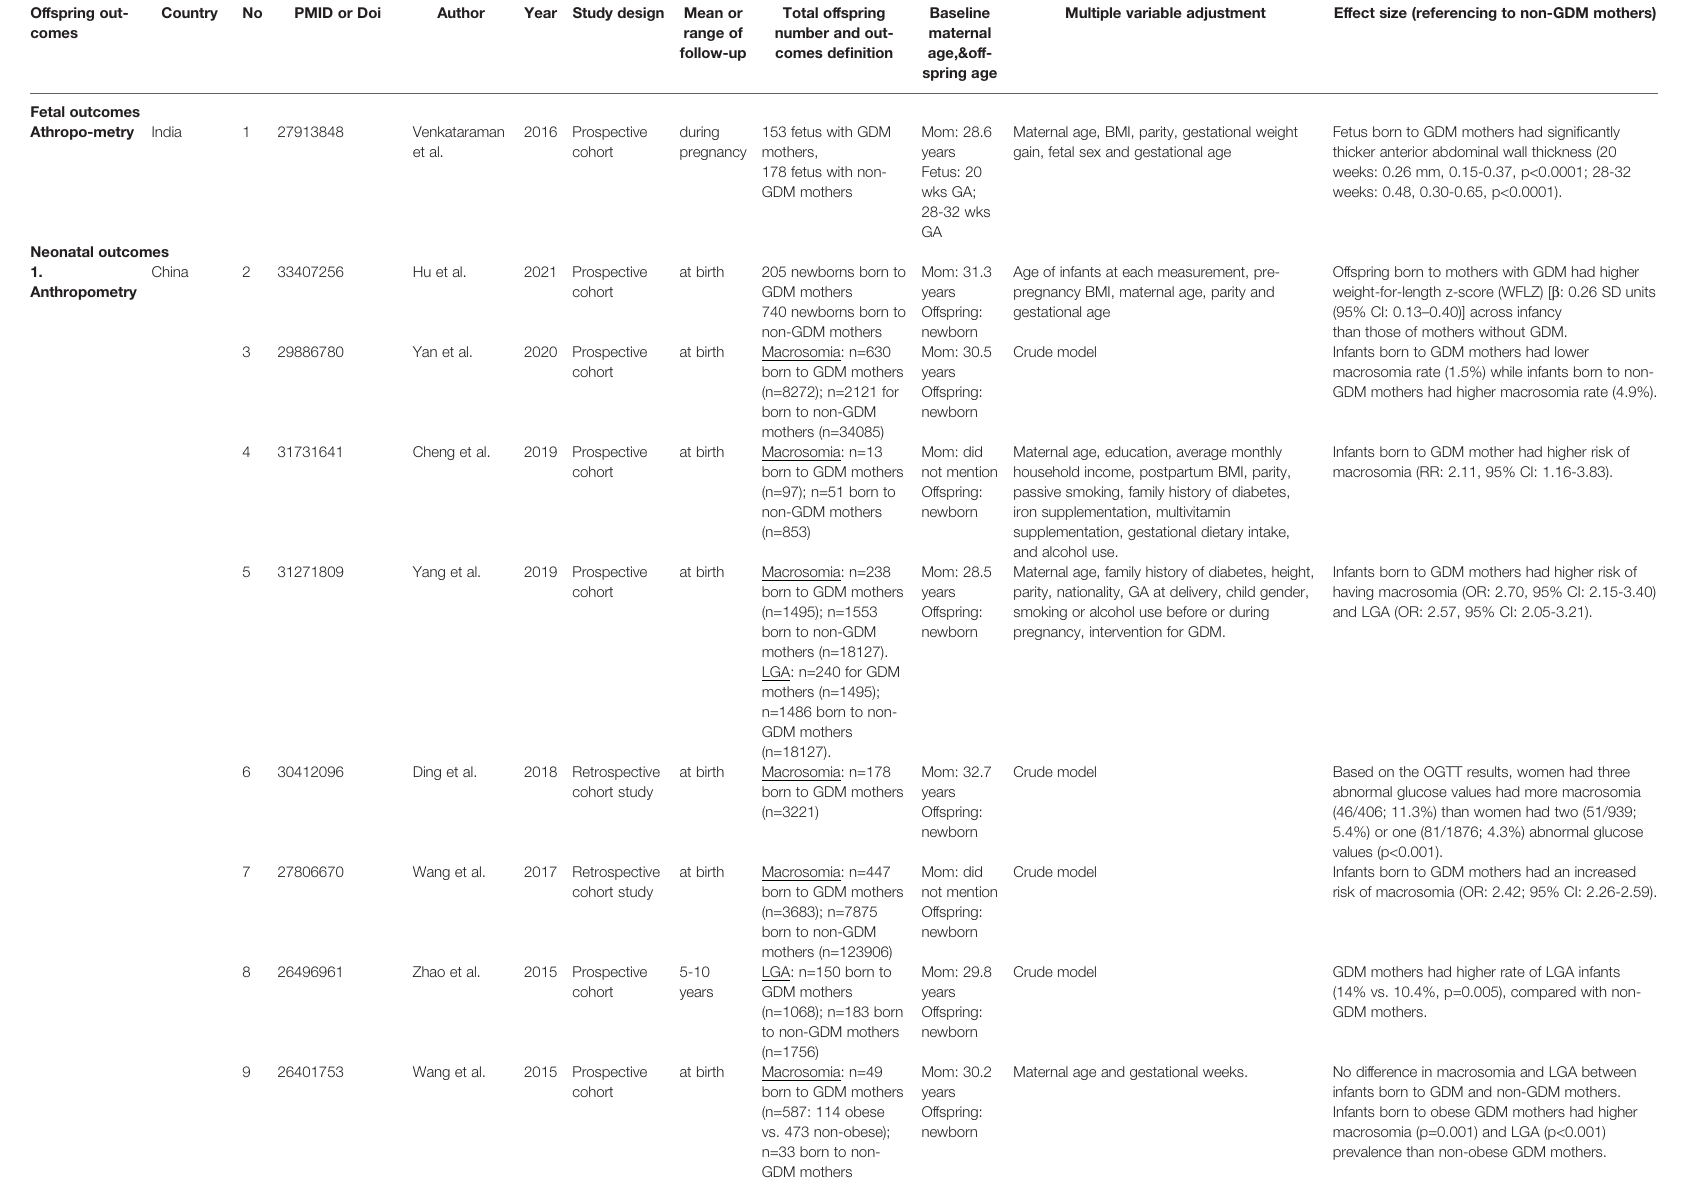
TABLE 2 | Summary of GDM-related offspring health outcomes in Asians. Offspring out- Country No PMID or Doi comes